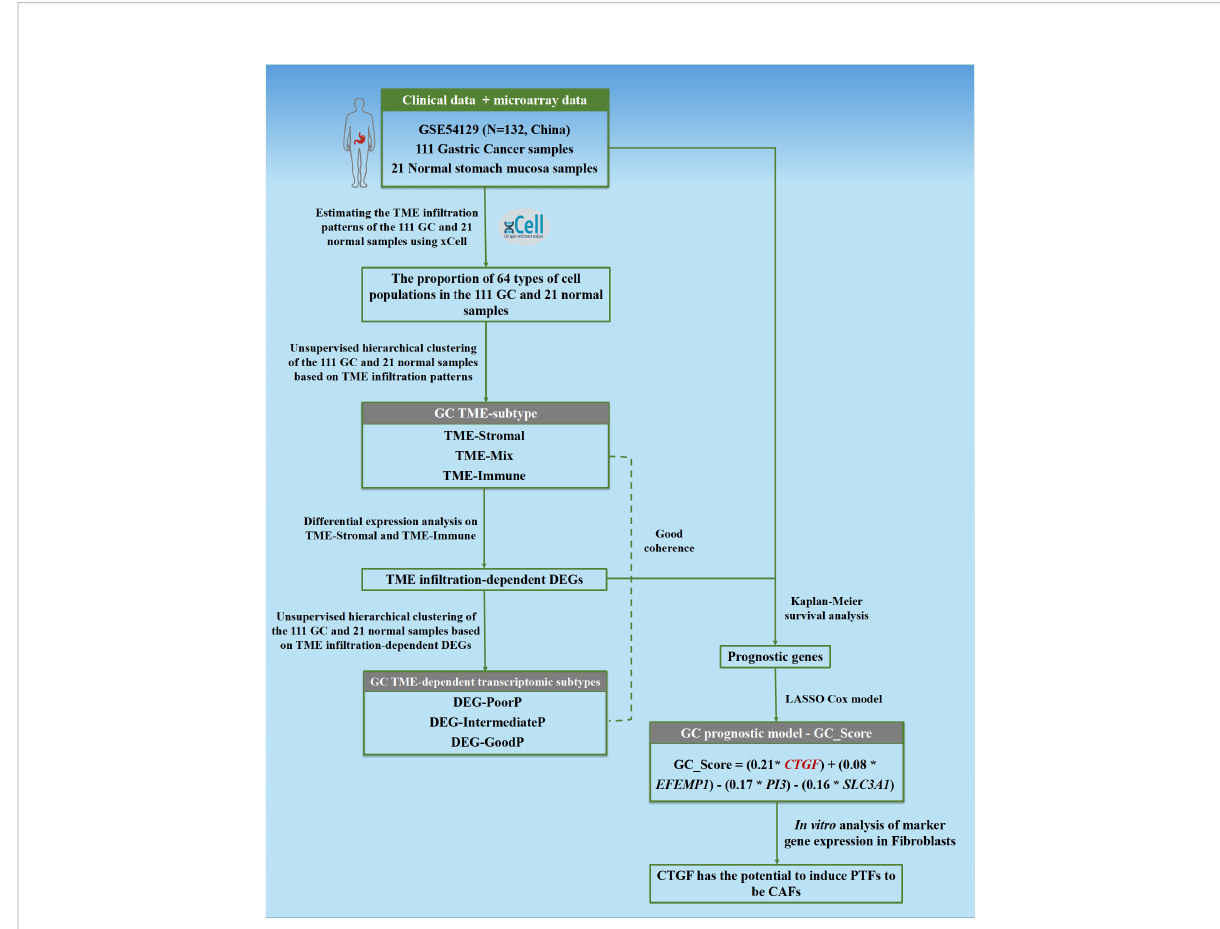
FIGURE 1 Flowchart of the study. The TME in fi ltration patterns of 111 GC and 21 normal stomach mucosa samples based on bulk transcriptomic pro fi les were estimated in this study, and a predictive model GC_Score for prognosis and drug responses with interpretability for carcinogenesis was developed. Furthermore, a TME-modulating gene, CTGF, was proposed to activate CAFs, thereby promoting the progression of